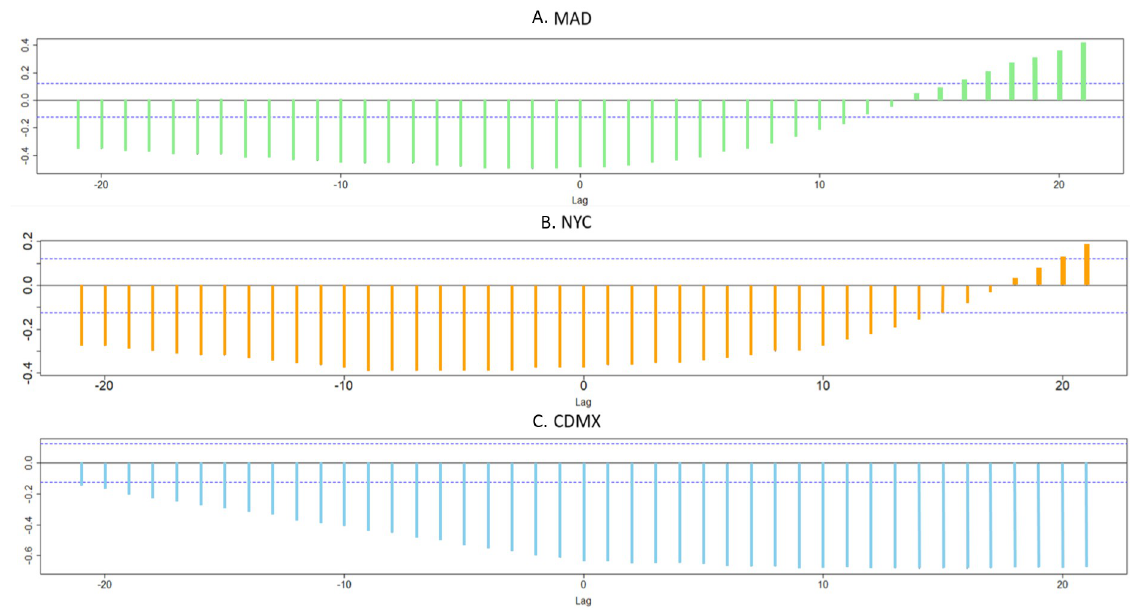
Fig 3. CCF between daily deaths and mobility for each